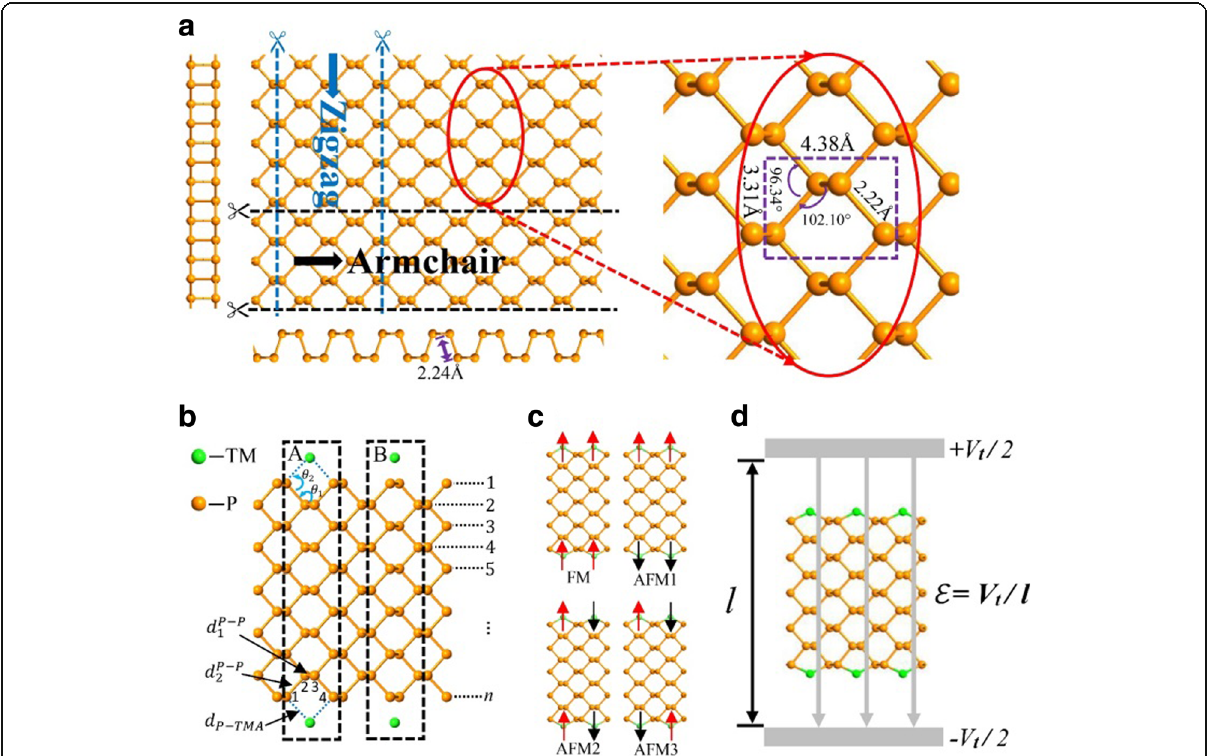
Fig. 1 a Top and side views of a 2D phosphorene with a zoom-in view on the right-hand side. The cross-sectional views from the armchair and zigzag edges are shown below and on the left-hand side, respectively. b An APNR with TM adatoms at hollow sites (A) and top sites (B) on edge. The dashed frames indicate the size of primitive cell, and the number n denotes the width of nanoribbon. c The four magnetic configurations of APNRs. d The schematic diagram in the presence of a transverse electric